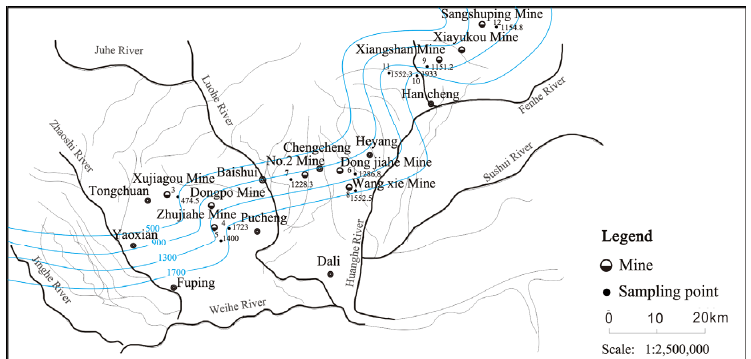
Figure 5. TDS contour line of Permian sandstone fissured aquifer.